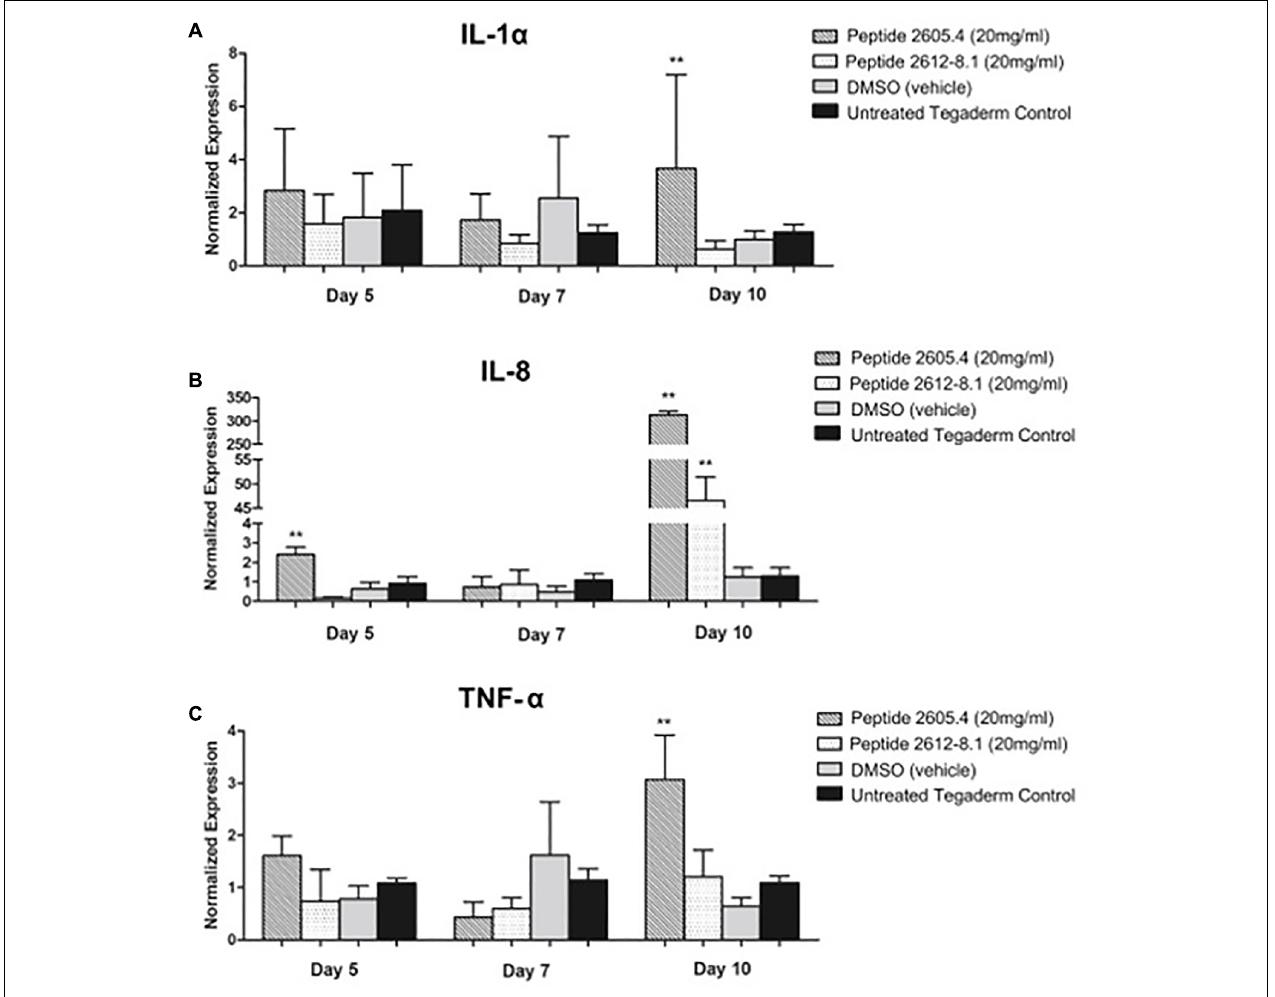
FIGURE 7 | Expression of pro-inflammatory cytokines IL-1 α , IL-8 and TNF- α was induced and prolonged in wounds treated with CLP 2605-4. Expression of IL-1 α (A) , IL-8 (B) and TNF- α (C) was assessed by qPCR on days 5, 7, and 10 post-treatment. The remaining text will be keep the same (see attached pdf and word version). Mean values of were presented after normalization to GAPDH ( n = 8 wounds per each treatment group). Error bars indicate SEM. Statistically significant differences were defined compared to vehicle control treated wounds; ** p <